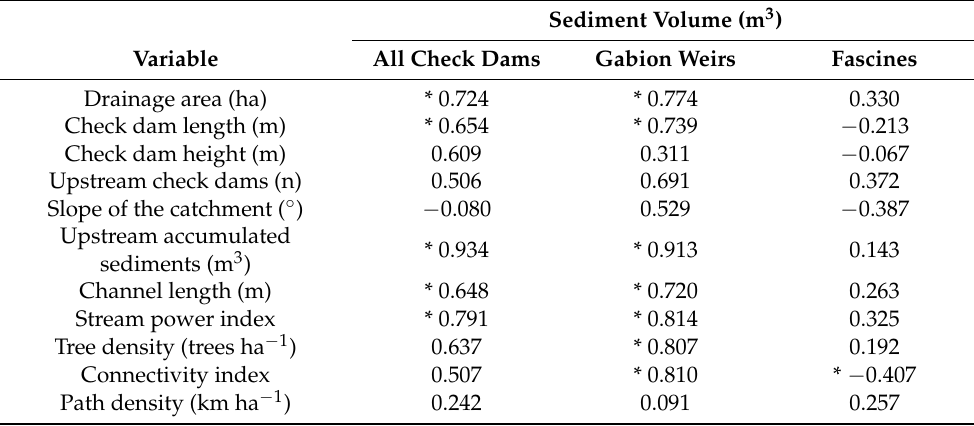
Table 6. Pearson correlation coefficient (r) between the sediment volume retained in check dams and topographic environmental variables ( n = 8 gabion weirs, n = 25 fascines). * Statistically significant values ( p <